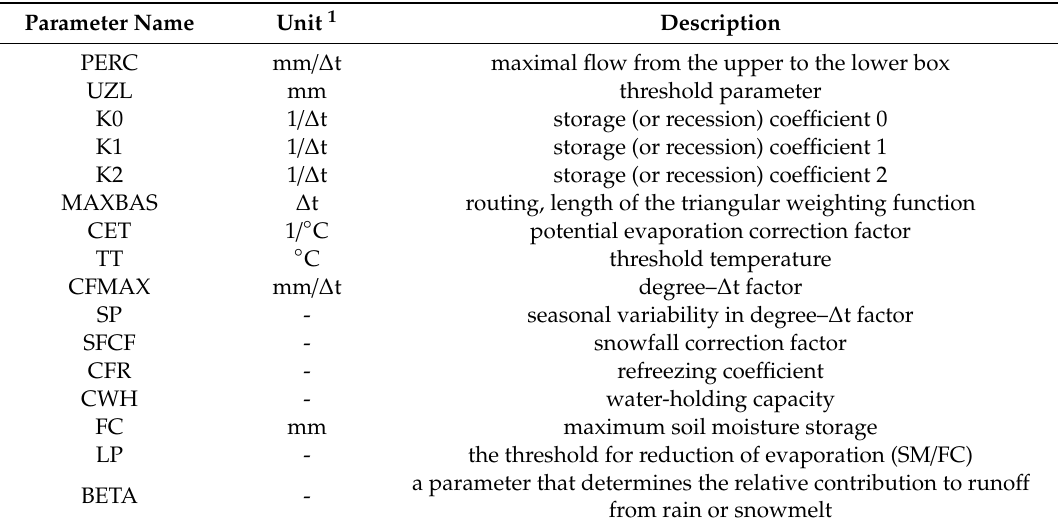
Table 1. List of parameters with their units and